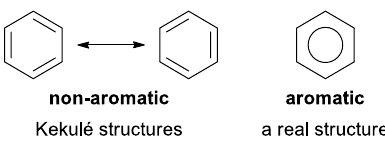
Reaction Scheme